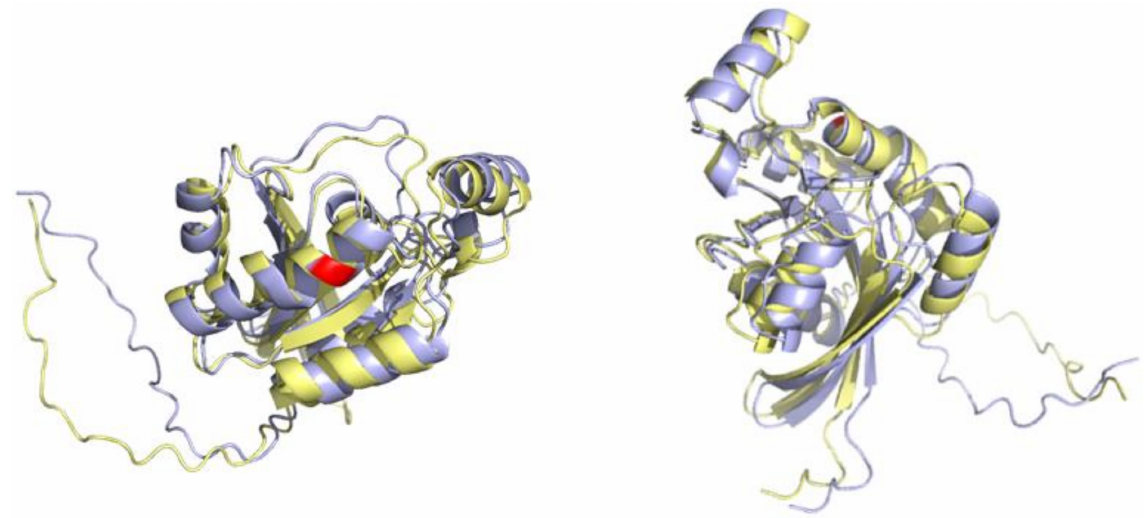
Figure 3. The 3D visualization of UniProt ID: P17081 (colored in yellow) and P17081_Q97R (colored in blue) using PYMOL. The mutated residue is colored red. The folded structure of mutant protein predicted by AlphaFold2 is roughly identical to the pre-mutant protein, except for some minor shifts. The RMSD between the structure of P17081 and P17081_Q97R is 0.046 Å calculated by PYMOL.